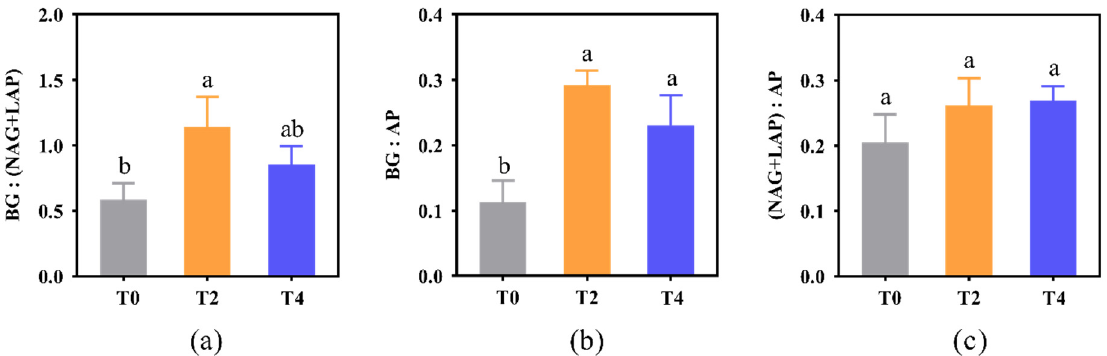
Figure 2. Changes in soil enzymatic stoichiometry under different treatments. ( a ) ratio of C metab- olizing enzyme to N metabolizing enzymes; ( b ) ratio of C metabolizing enzyme to P metabolizing enzyme; ( c ) ratio of N metabolizing enzymes to P metabolizing enzyme. BG: β -1,4-glucosidase; NAG: β -1,4- N -acetylglucosidase; LAP: L-leucine aminopeptidase; ACP: acid phosphatase. T0: con- trol without warming; T2: 2 ◦ C warming treatment; T4: 4 ◦ C warming treatment. Lowercase letters represent significant differences in soil enzyme activity under different treatments ( p <